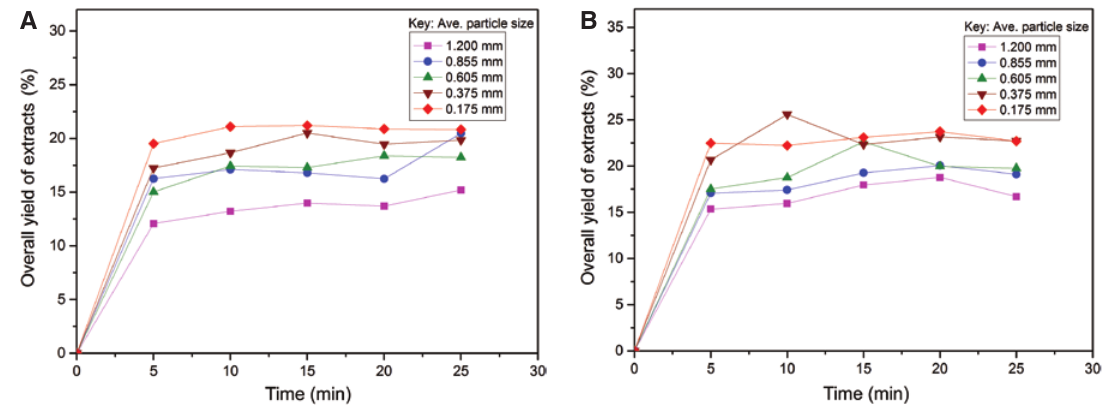
Figure 5: Effect of particle size on the overall yield of extracts from Andrographis paniculata (AP) in the green solid-liquid extraction of andrographolide at 80 ° C for solid-liquid ratio of (A) 1:10 (g ml -1 ) and (B) 1:50 (g ml -1 ).